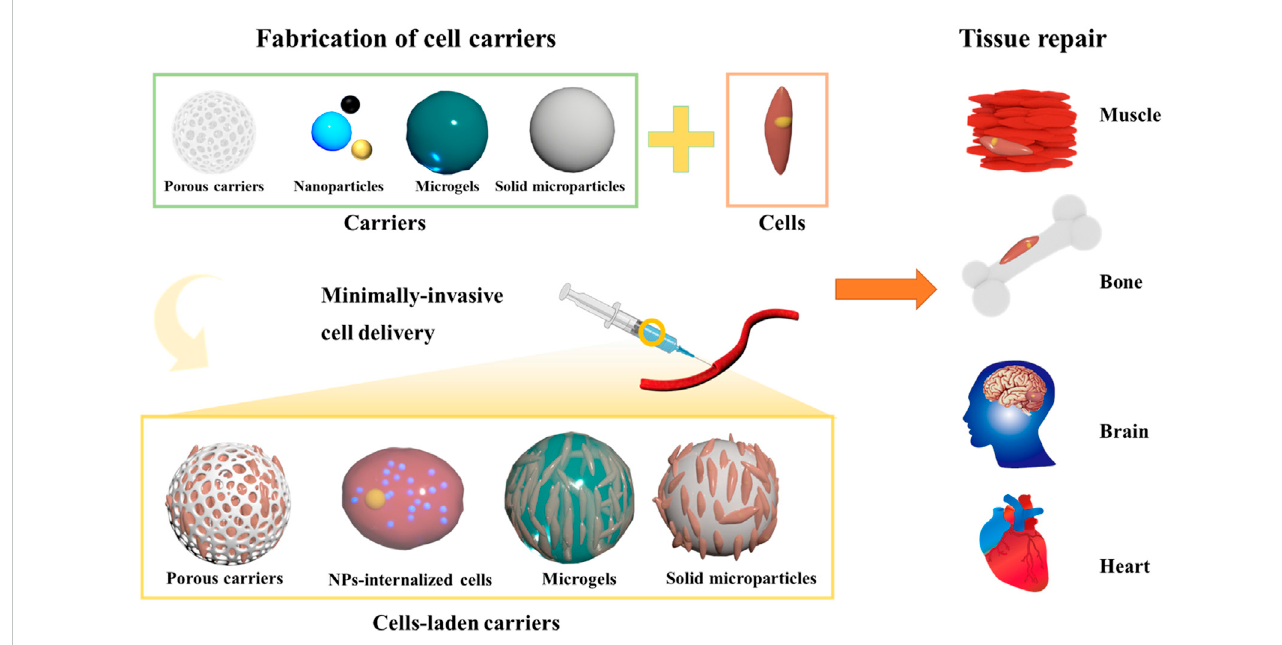
FIGURE 1 Schematic illustrating several kinds of 3D microcarriers for cell delivery